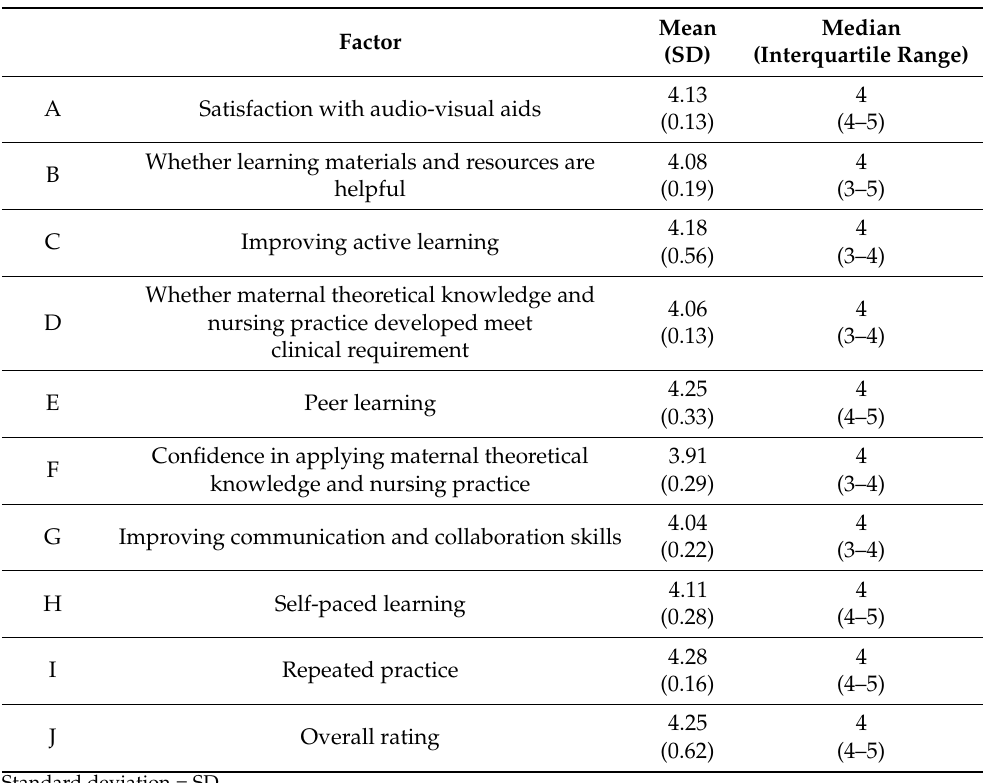
Table 1. Descriptive data of learning satisfaction ( n =